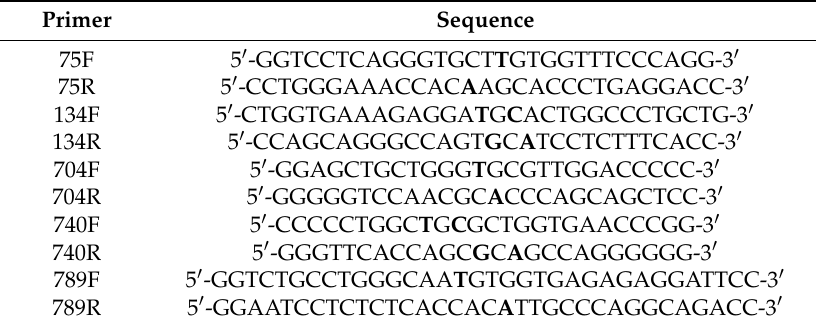
Table 2. Primer pairs used for site directed